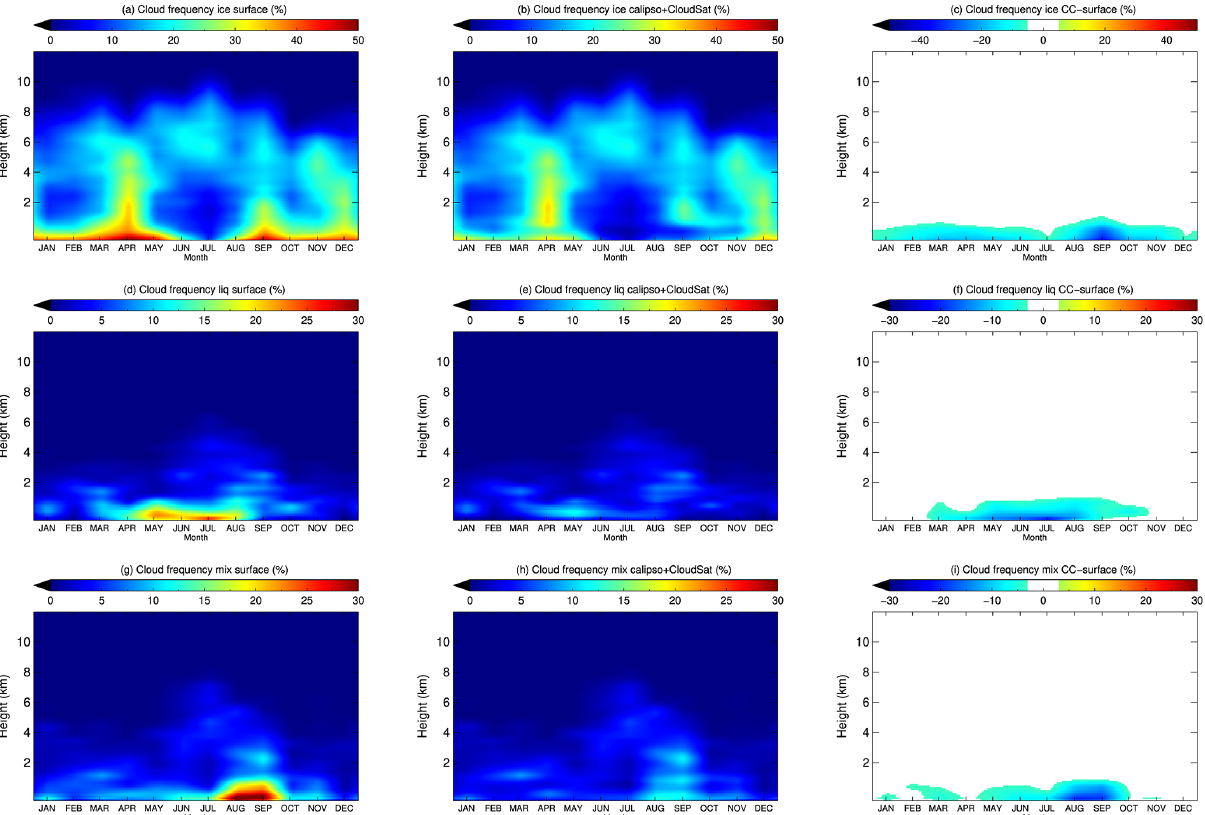
Figure 6. Cloud vertical distribution from surface observations for (a) ice, (d) liquid, and (g) mixed-phase clouds, from combined CloudSat and CALIPSO for (b) ice, (e) liquid, and (h) mixed-phase clouds, and their differences for (c) ice, (f) liquid, and (i) mixed-phase clouds during the SHEBA experiment.